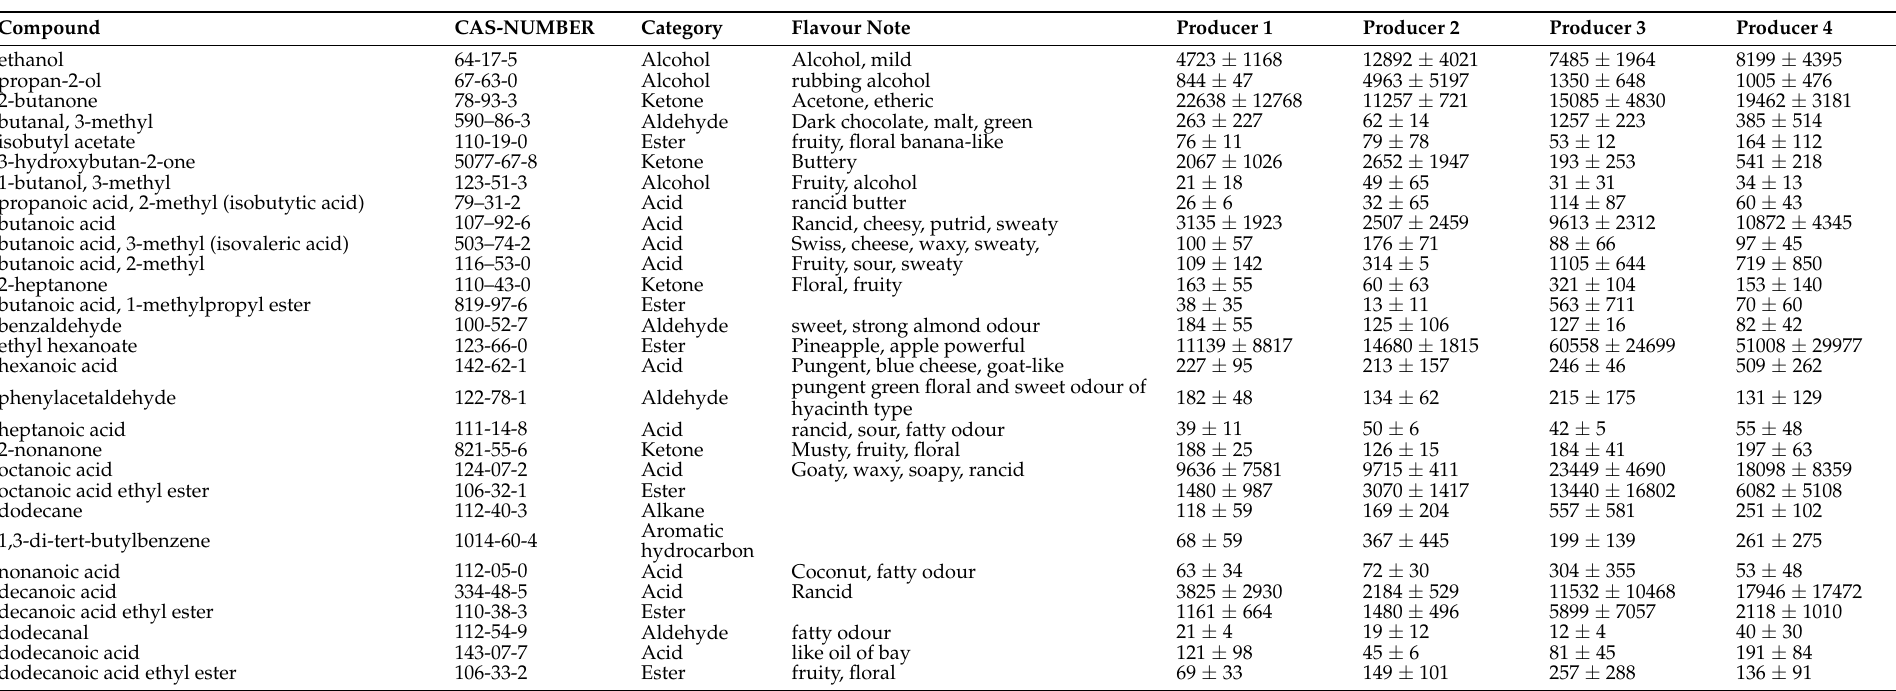
Table 7. Volatile compounds (mean ± SD 1 of two cheese samples from the same batch) detected by SPME in the headspace of Queijo Serra da Estrela PDO